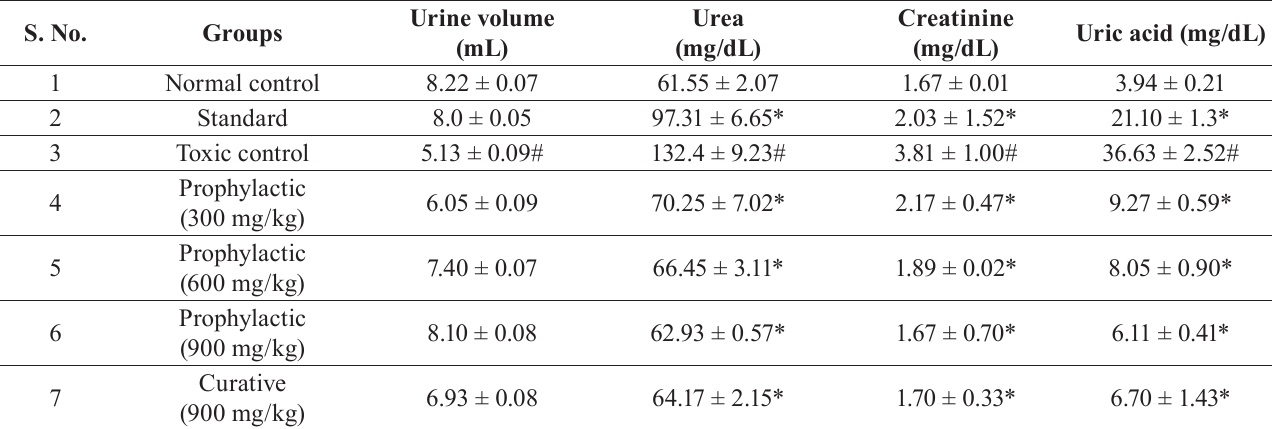
TABLE IV - Biochemical analysis of Malva neglecta methanol extract in urine